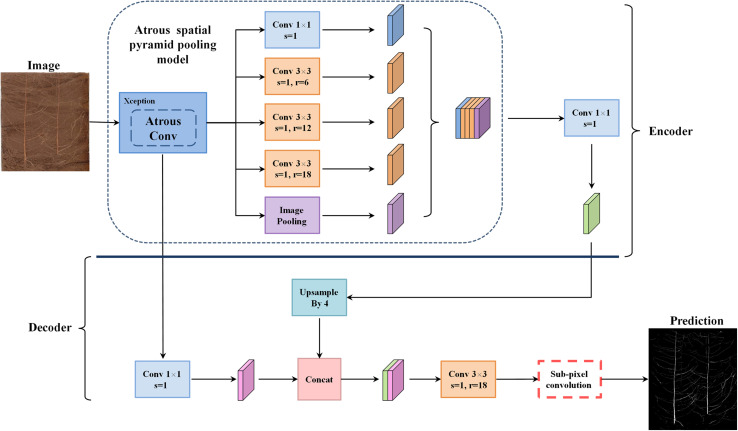
The proposed network architecture.